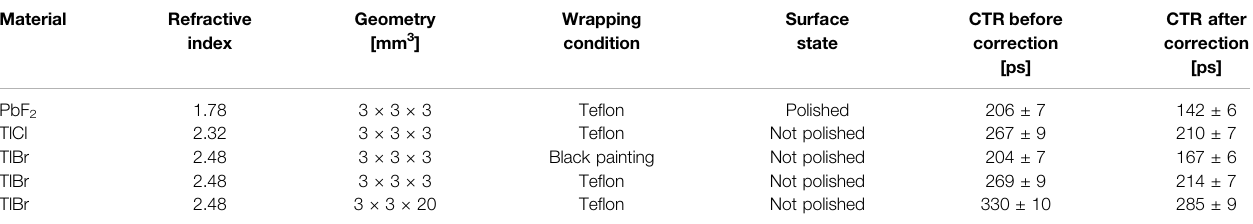
TABLE 2 | Summary of the CTR measurements performed using three materials with different refractive indexes and different geometries. The crystal dimensions and wrapping are listed together with the extracted coincidence time resolution (CTR) before and after time-walk correction.